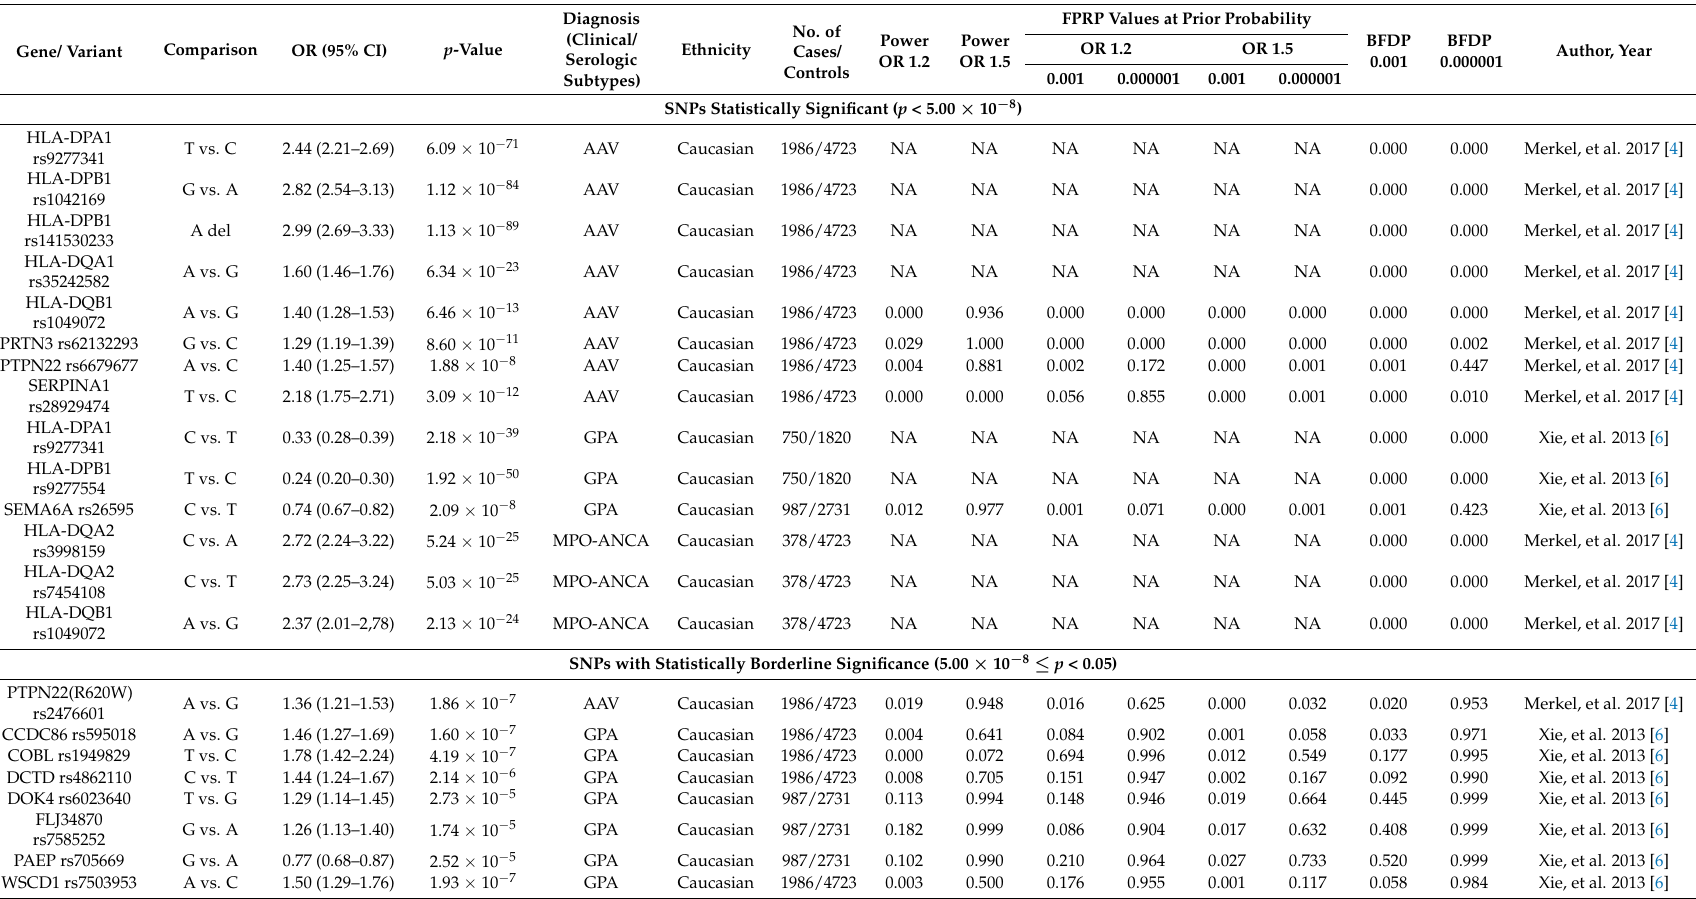
Table 3. Results of meta analyses (combined analysis) with genome-wide association studies and replication cohort. Noteworthy genetic variants with satisfied FPRP or BFDP values are presented. SNPs: single nucleotide